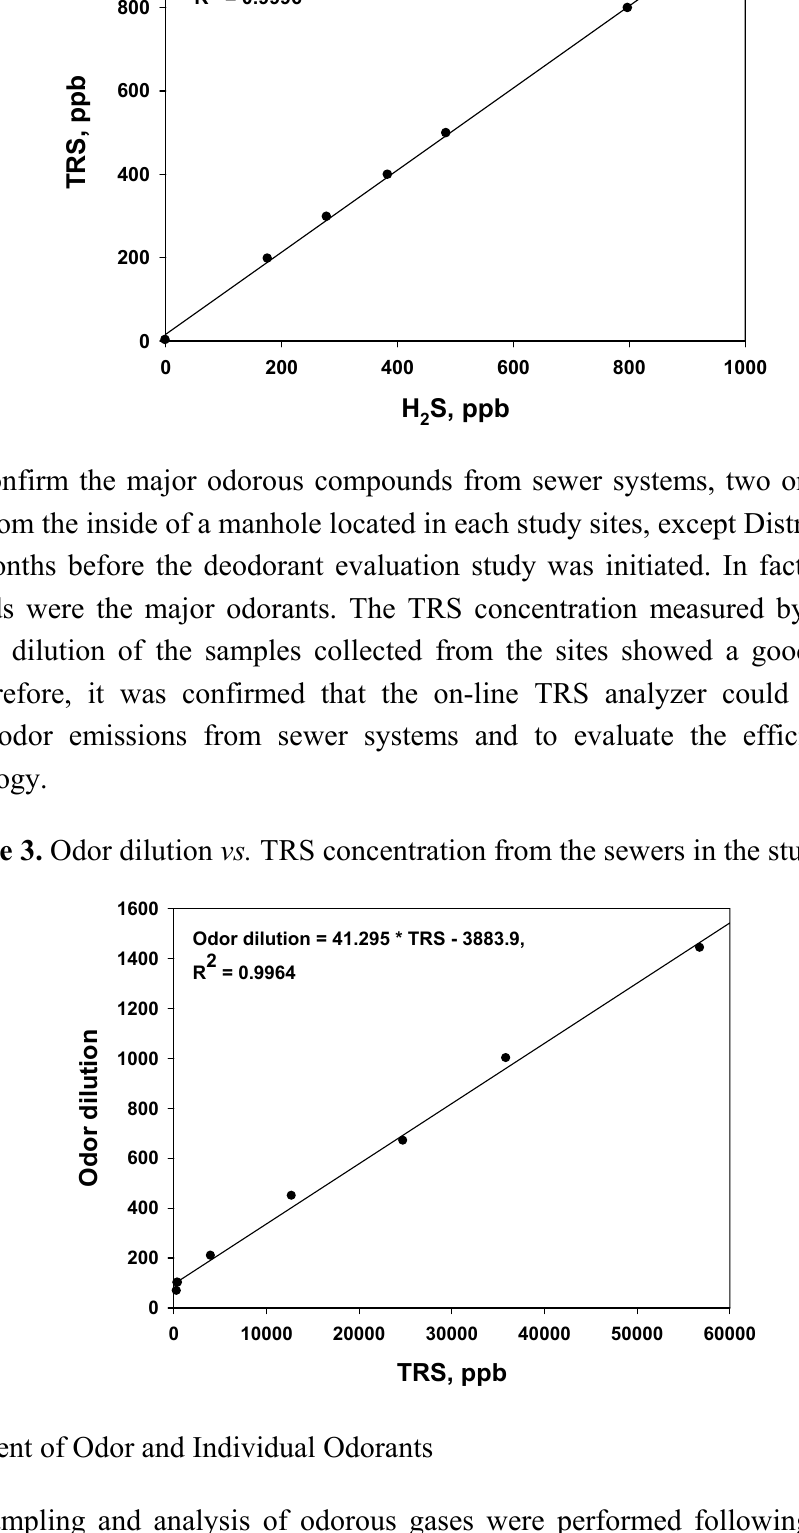
Figure 2. Example calibration curve for on-line TRS analyzer against standard H